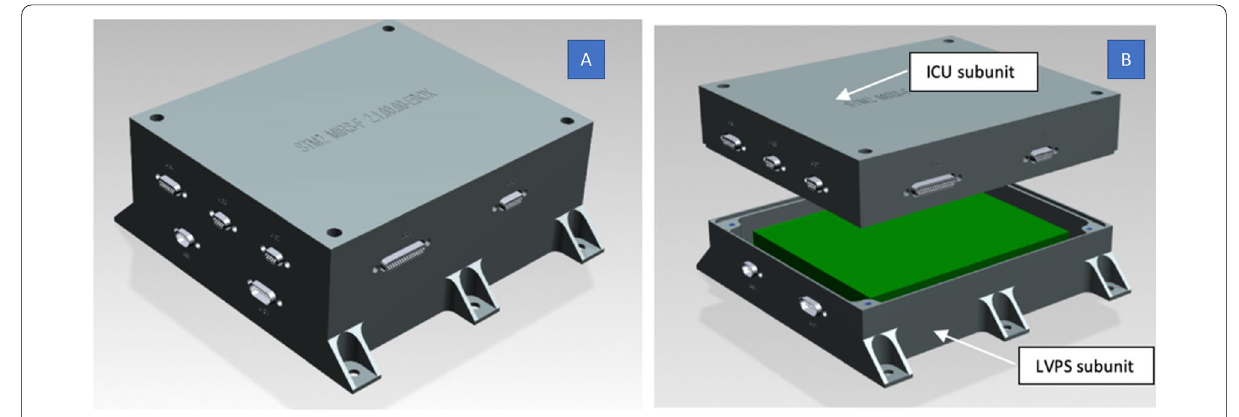
Fig. 9 MIRS EBOX. Assembled view ( A ), separated view ( B